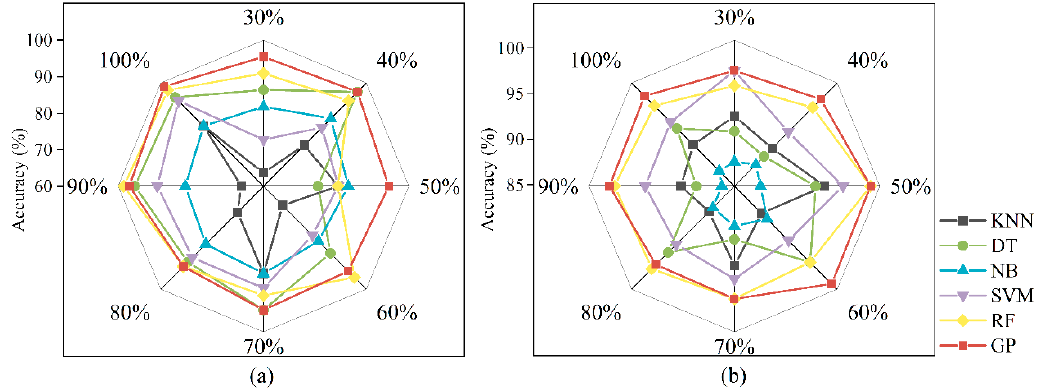
Figure 8. Effect of sample size on six classifiers in Area 1 ( a ) and Area 2 ( b ).